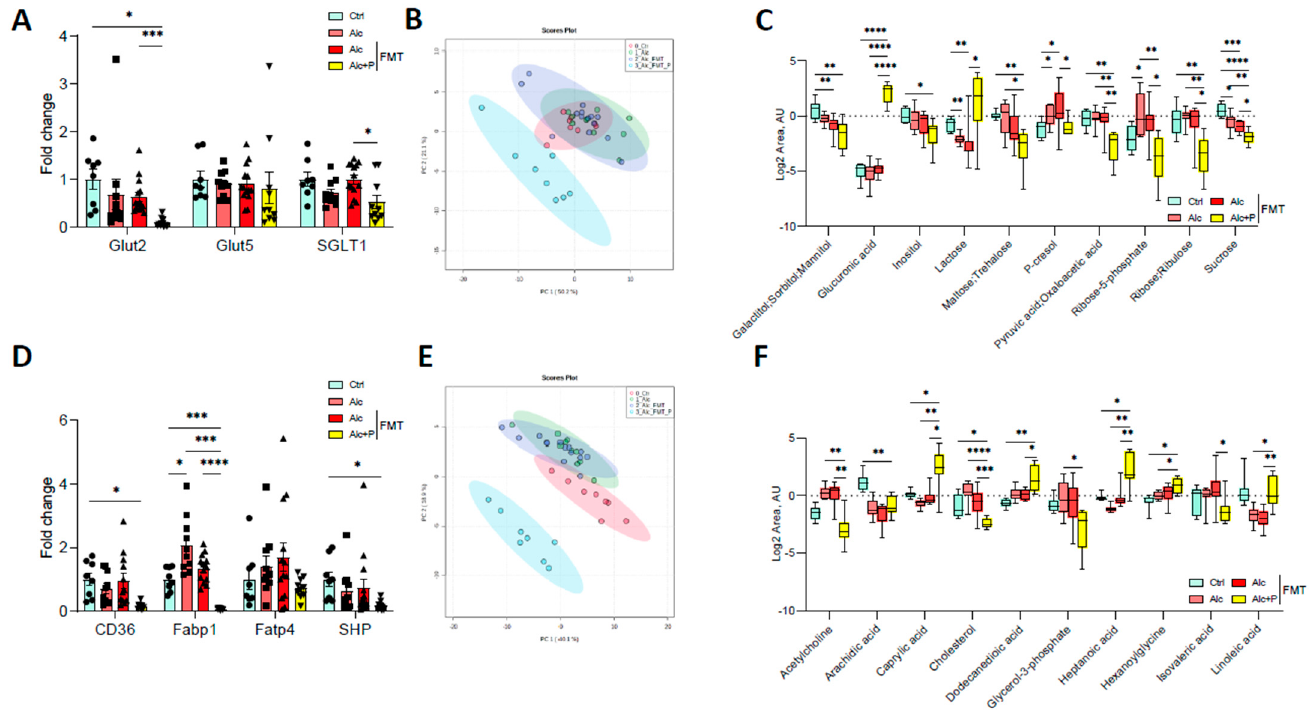
Figure 6. Alterations in sugar and lipid metabolism induced by pectin. Control (Ctrl) and alcohol- fed (Alc) mice received a Lieber DeCarli diet with isocaloric maltodextrin or alcohol, respectively. Pectin-treated mice (Alc + p ) received 6.5% pectin in addition to 5% ethanol. Human fecal microbiota transfer (FMT) groups received the microbiota of a patient with alcoholic hepatitis. Quantification of mRNA levels of glucose transporters (glucose transporter 2 and 5, Glut2, Glut5; Sodium/glucose cotransporter 1, SGLT1) ( A ) and lipid transporters (cluster of differentiation 36, CD36; fatty acid binding protein 1, Fabp1; fatty acid transporter 4, Fatp4; small heterodimer partner, SHP) ( D ) by qPCR. Principal component analysis of fecal glucose-metabolites ( B ) and fecal lipid metabolites ( E ). Carbohydrates ( C ) and lipid ( F ) metabolite quantification in feces. * p < 0.05, ** p < 0.01, *** p < 0.001, **** p < 0.0001.